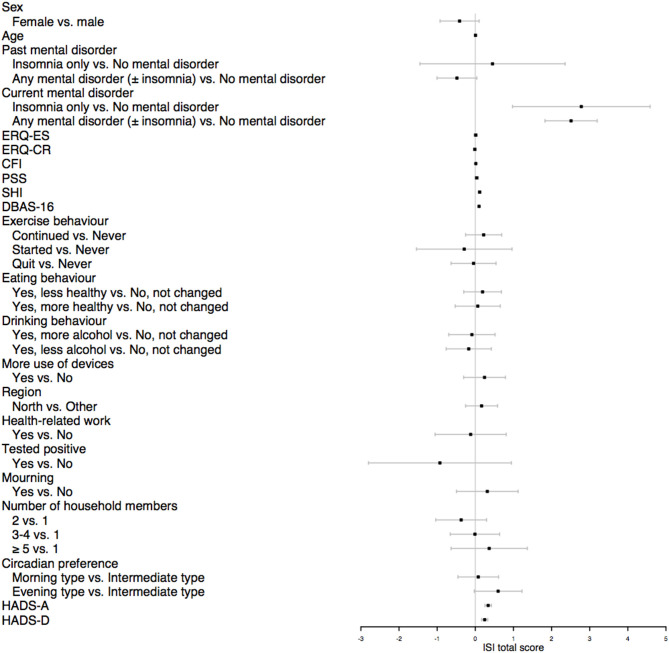
Forest plot of multivariable linear regression. Results were plotted as unstandardized beta coefficients with 95% Confidence Intervals. ERQ, Emotion Regulation Questionnaire; ES, expressive suppression; CR, cognitive reappraisal; CFI, Cognitive Flexibility Inventory; PSS, Perceived Stress Scale; SHI, Sleep Hygiene Index; DBAS-16, Dysfunctional Beliefs and Attitudes about Sleep; HADS, Hospital Anxiety and Depression Scale; HADS-A, anxiety symptoms; HADS-D, depressive symptoms.